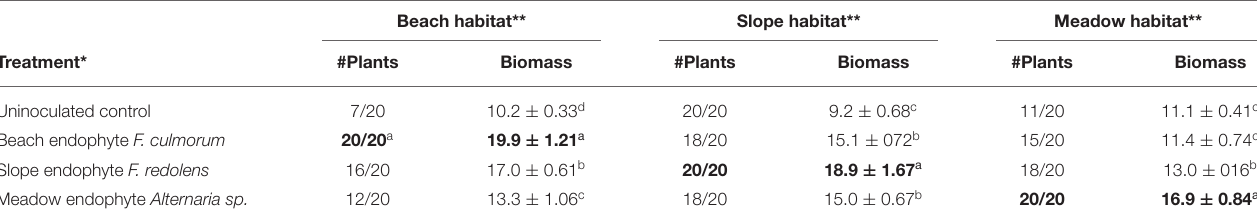
TABLE 2 | Reciprocal transplant study on Cedar Rocks